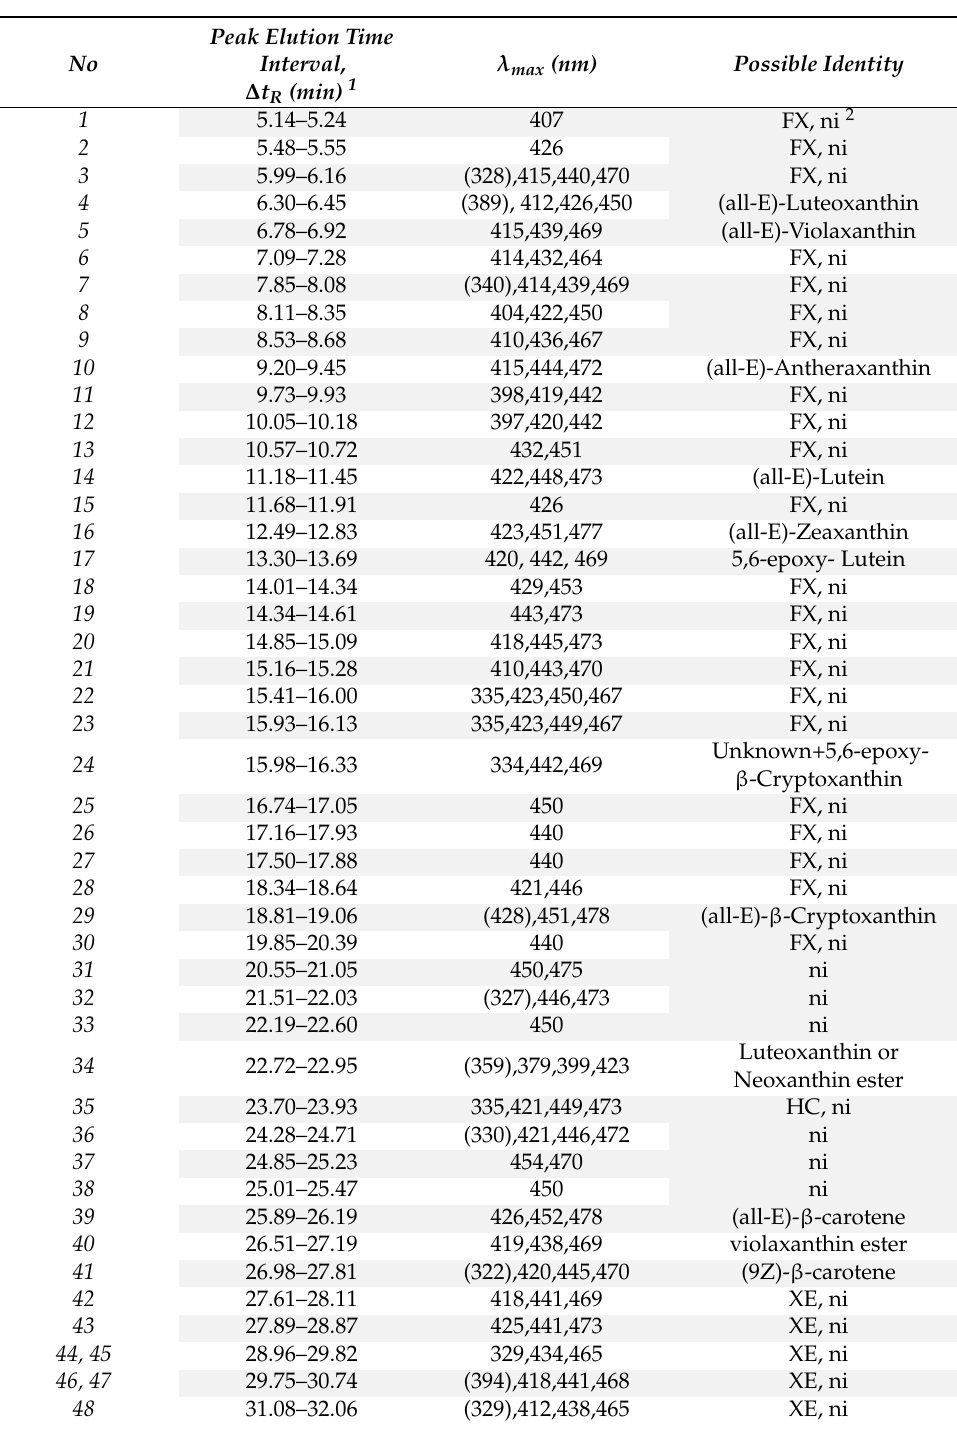
Table A1. Carotenoid elution order on reverse phase-C30 column, visible, and mass spectral char- acteristics of peaks (S/N > 3) that presented the carotenoid-specific fine structure in the spectral region between λ = 410 − 470 nm and possible identity based also on the comparison with standard compounds and literature data